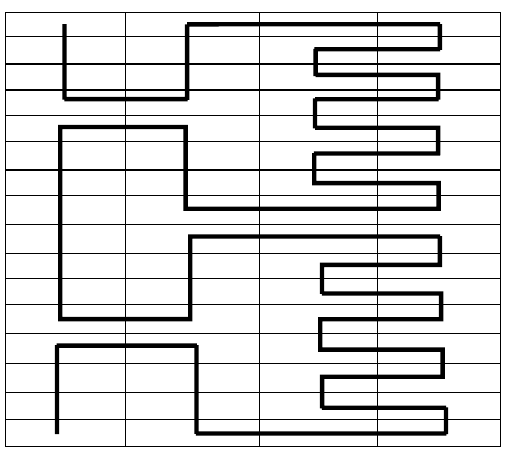
Figure 2.9. Next iteration when started with method VL.